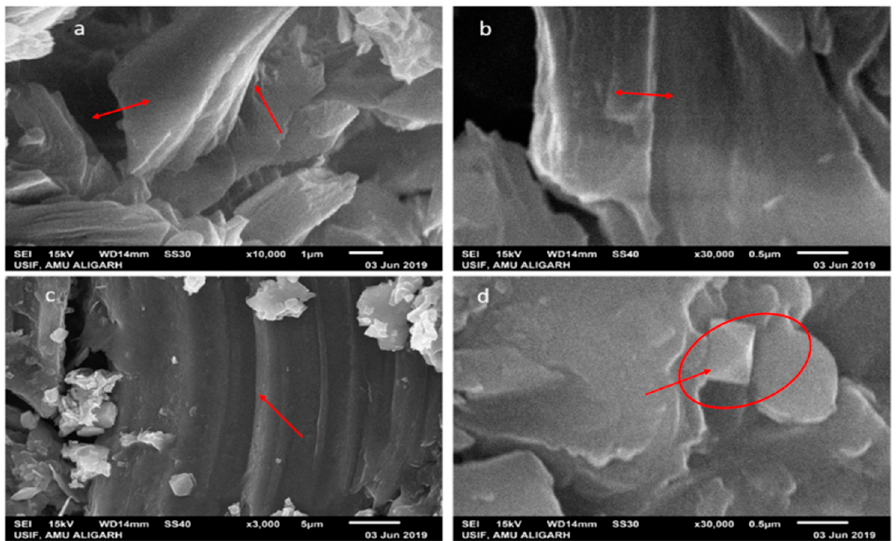
Figure 3. XRD graph of ( a ) GOX and ( b ) RGOX.